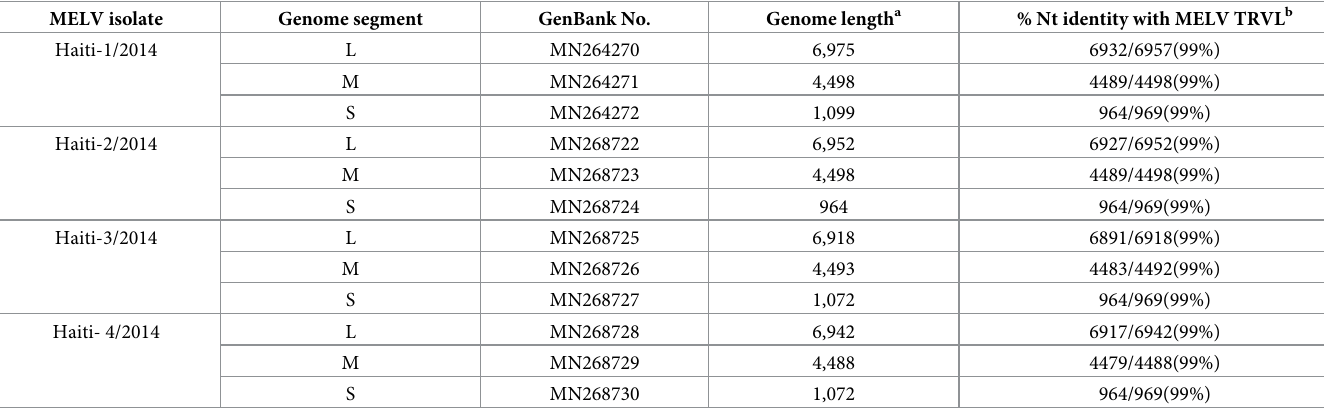
Table 1. GenBank accession nos. and complete or partially complete genome segment lengths (rnt) of MELV/Homo sapiens/Haiti/2014 isolates 1–4. MELV isolate Genome segment GenBank No. Genome length a % Nt identity with MELV TRVL b